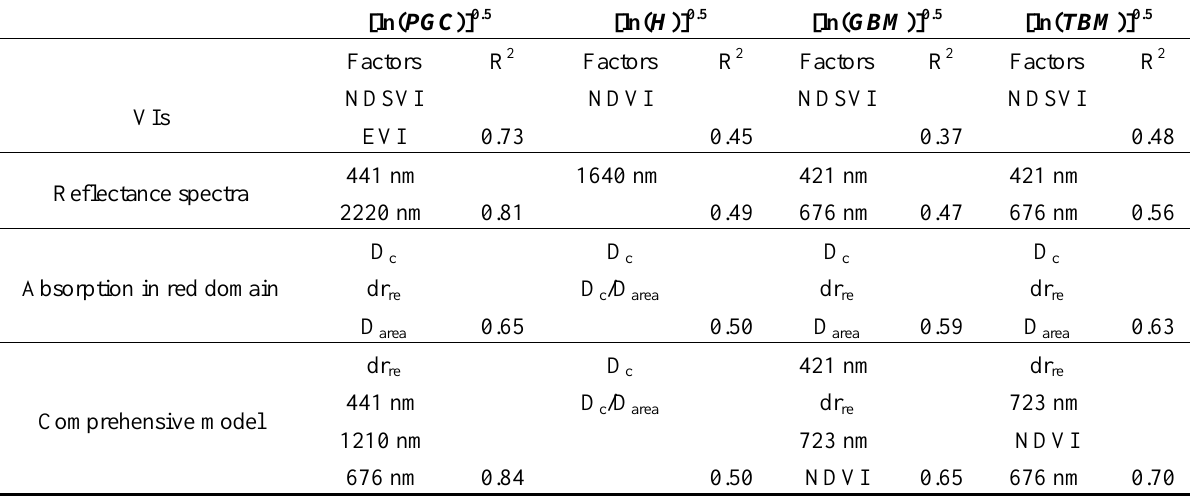
Table 4. Empirical models and performances of the general linear model with disturbance as a class variable ( n = 61). Class I: less human disturbances in the typical steppe, Class II: more disturbances in the typical steppe, and Class III: desert